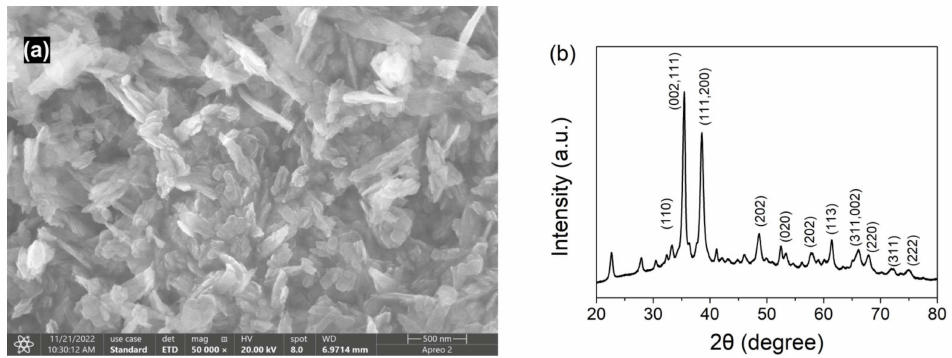
Figure 1. ( a ) SEM image of CuO nanoparticles; ( b ) XRD pattern of CuO